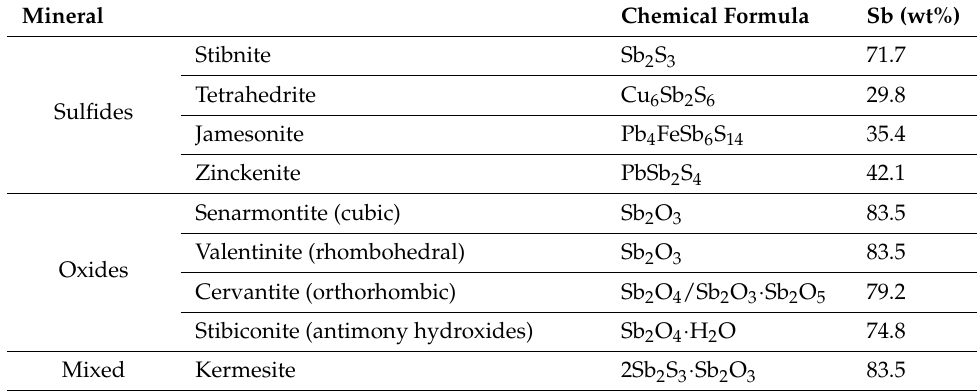
Table 3. Minerals of antimony with industrial significance.